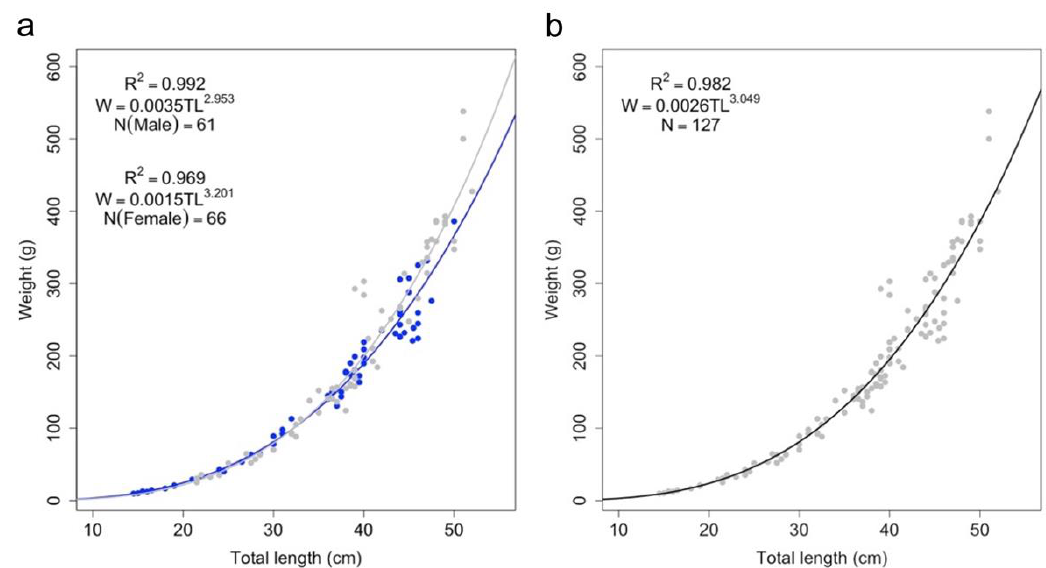
Figure 3. Total length–weight relationships of G. melastomus for both sexes: ( a ) females (gray, N = 66) and males (blue, N = 61) and ( b ) combined.